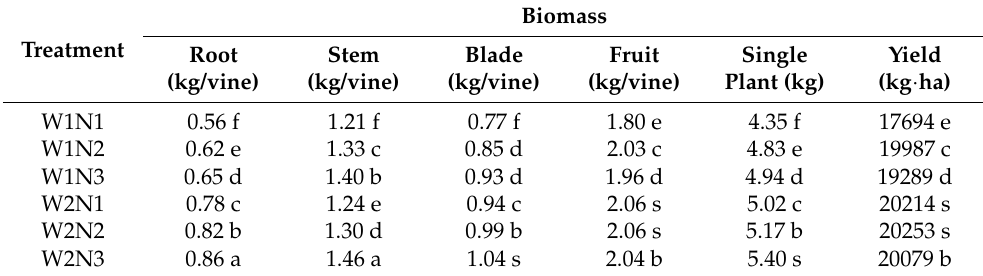
Table 4. Biomass of different vine